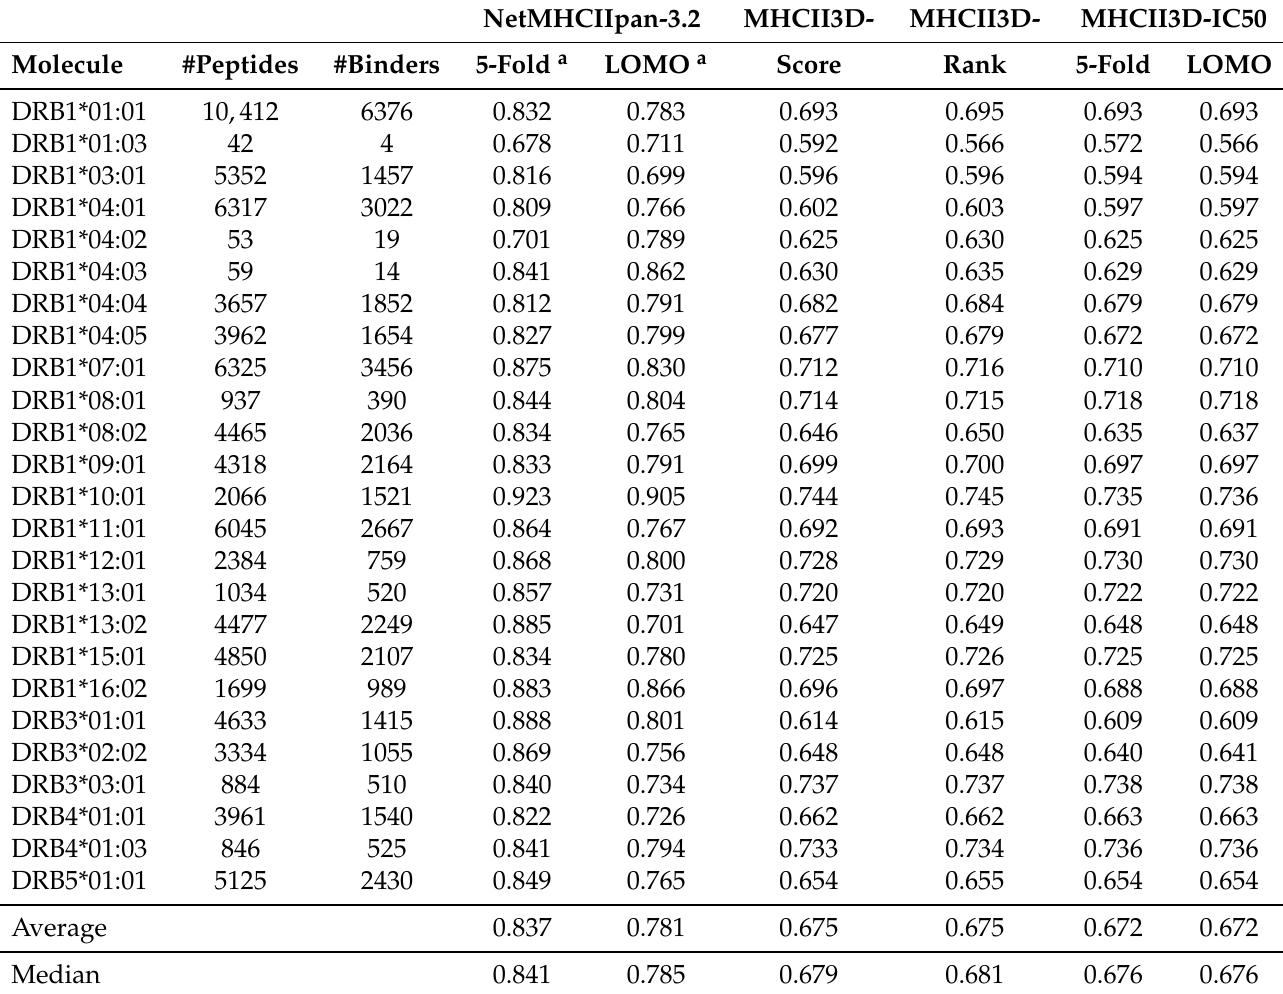
Table 5. Comparison of prediction performances between NetMHCIIpan-3.2 and MHCII3D. a Values derived from Jensen et al. [31]. Results for a five-fold cross-validation experiment (5-fold) and a leave-one-molecule-out (LOMO) experiment, as defined by Jensen et al. are